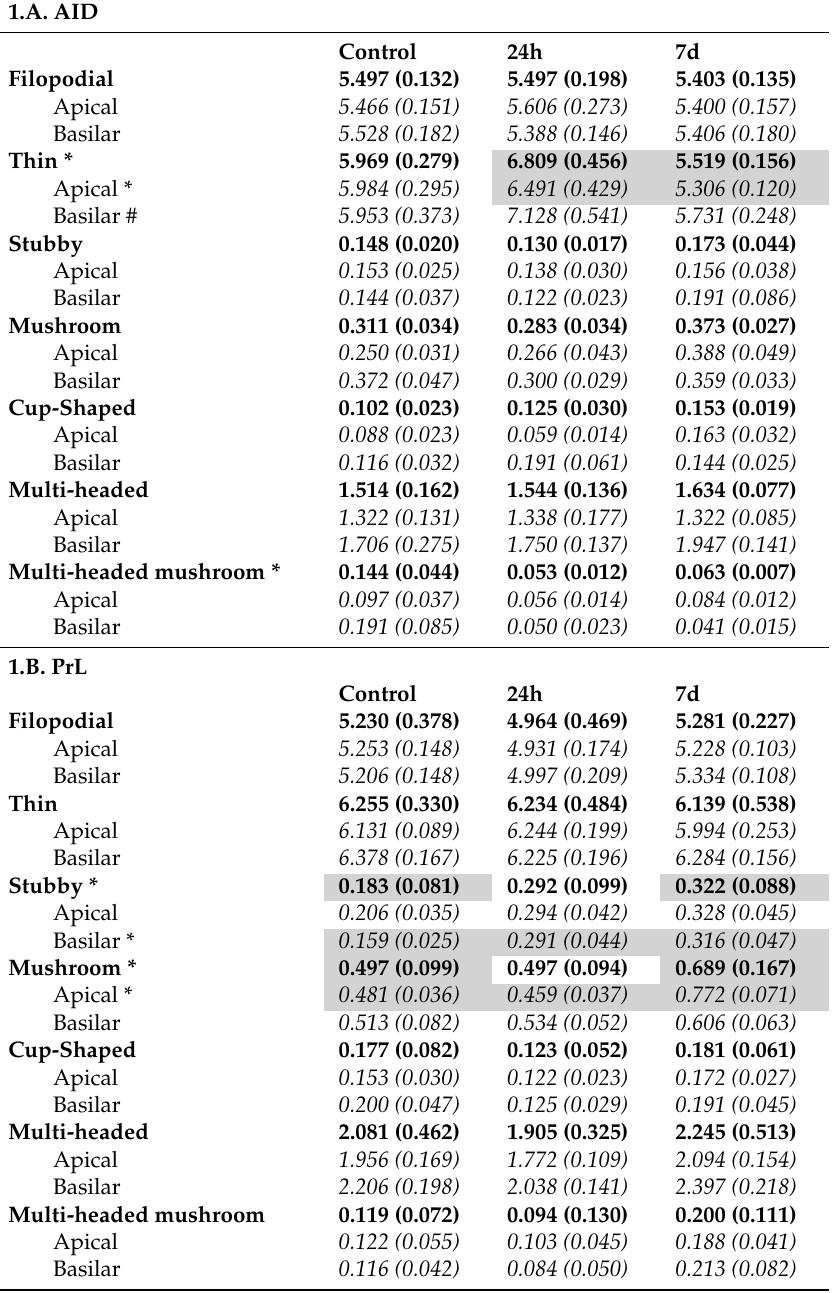
Table 1. Mean (SEM) spine density (spines / 10 µ m) in AID (1A) and PrL (1B) for filopodial, thin, stubby, mushroom, cup-shaped, multi-headed, and multi-headed mushroom spines in each group. * p < 0.05, # p = 0.052. Total measures (averaged apical and basilar field data) are shown in bold text. Apical and basilar means are shown in italics. Grey shaded means indicate significant post-hoc comparisons ( p < 0.05). For mushroom spines in the apical field of PrL post-hoc comparisons showed the 7 d group had significantly more spines than the control and 24 h groups, and controls had fewer stubby spines than both withdrawal